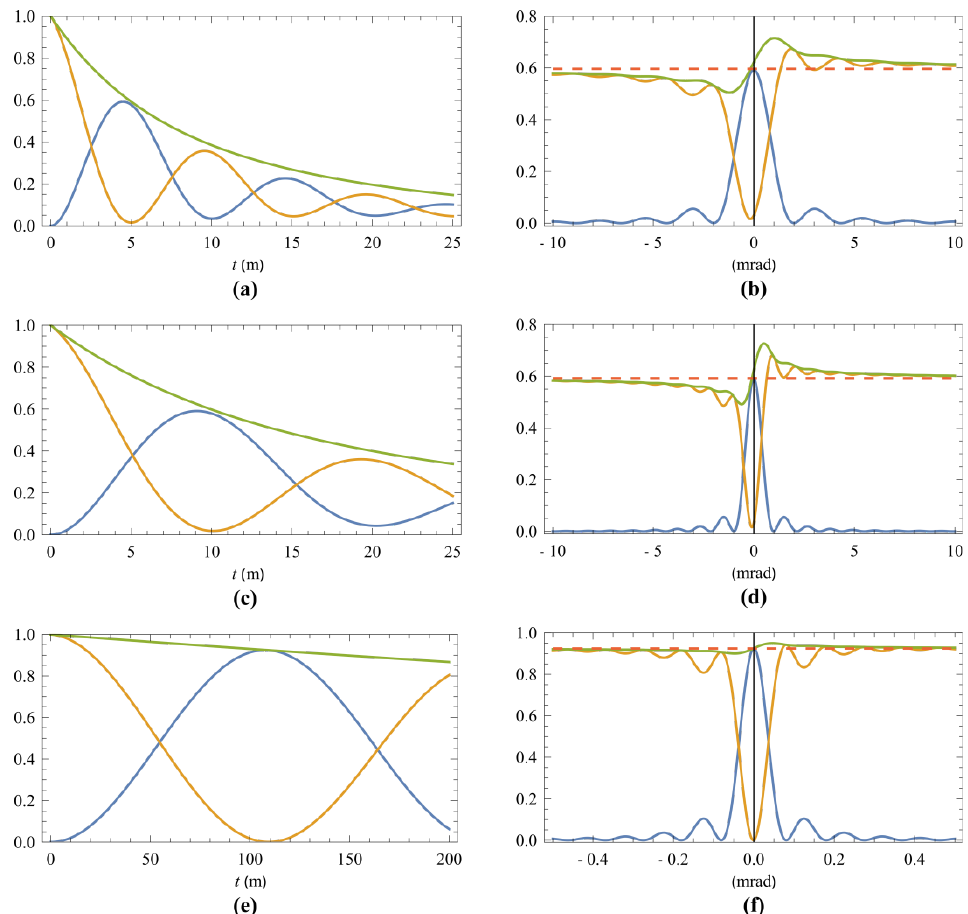
Figure 2. Plots of the diffraction efficiencies of the focused beam (blue), refracted beam (orange), and total transmission (green) of MLLs. ( a , c , e ): Efficiencies as a function of MLL thickness. ( b , d , f ): Efficiencies as a function of the deviation of the incident angle from the Bragg condition for MLLs of optimum thickness. The dashed red line is the total transmission of a homogeneous material of the same average composition from Equation (2), revealing anomalous transmission for Δ𝜃 > 0 .